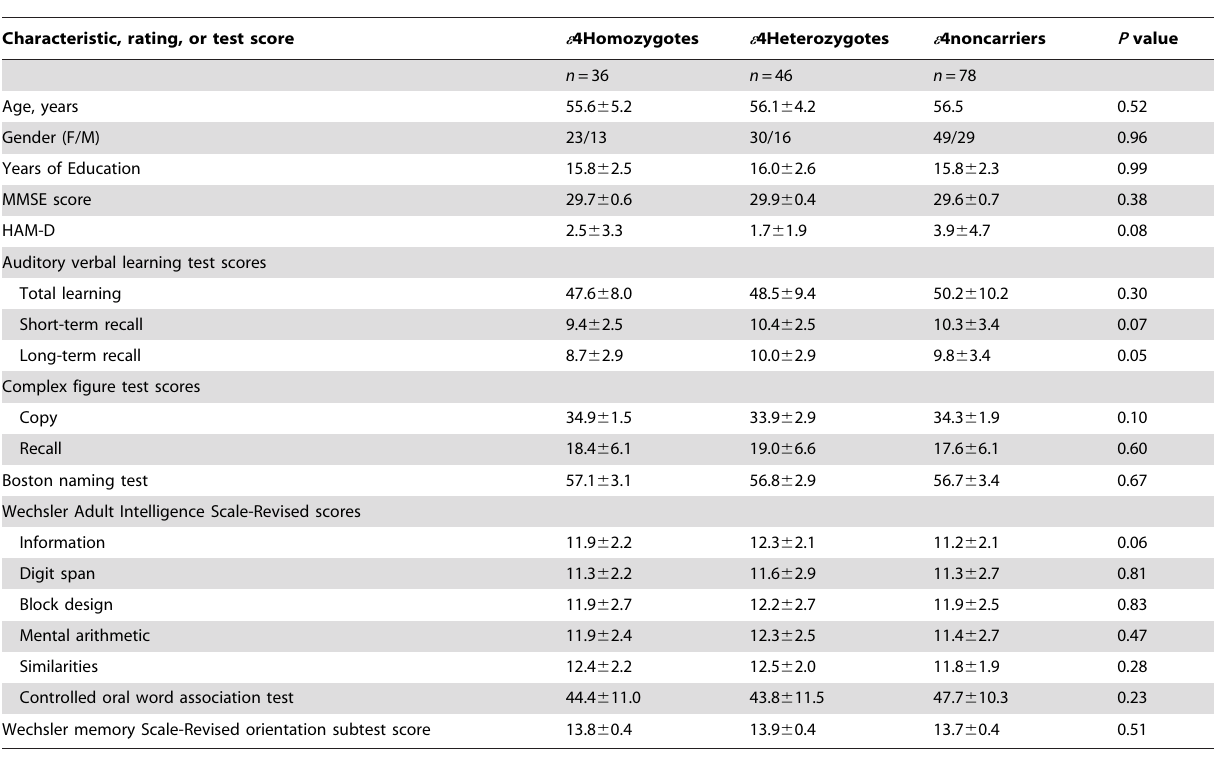
Table 1. Subject characteristics, clinical ratings, and neuropsychological test scores.